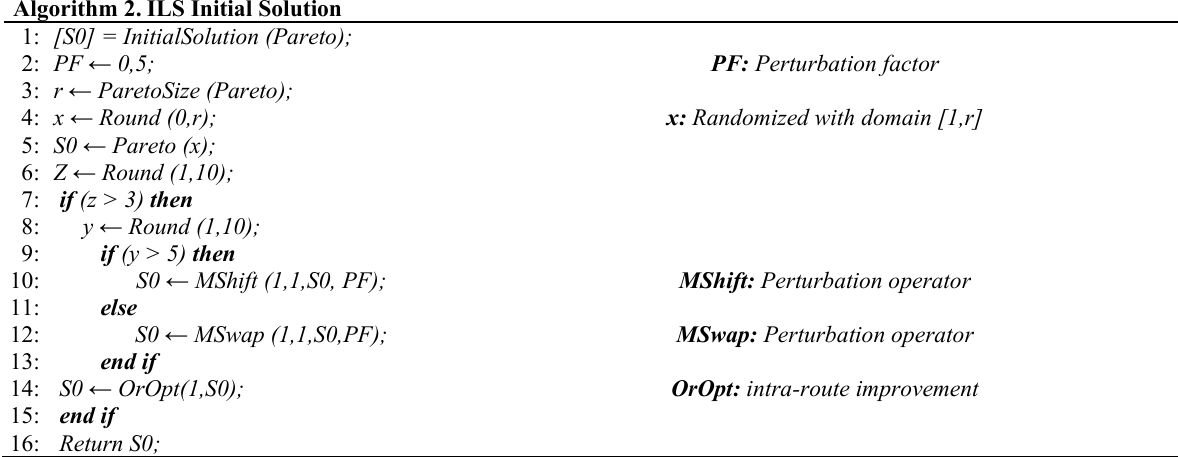
Algorithm 2. ILS Initial